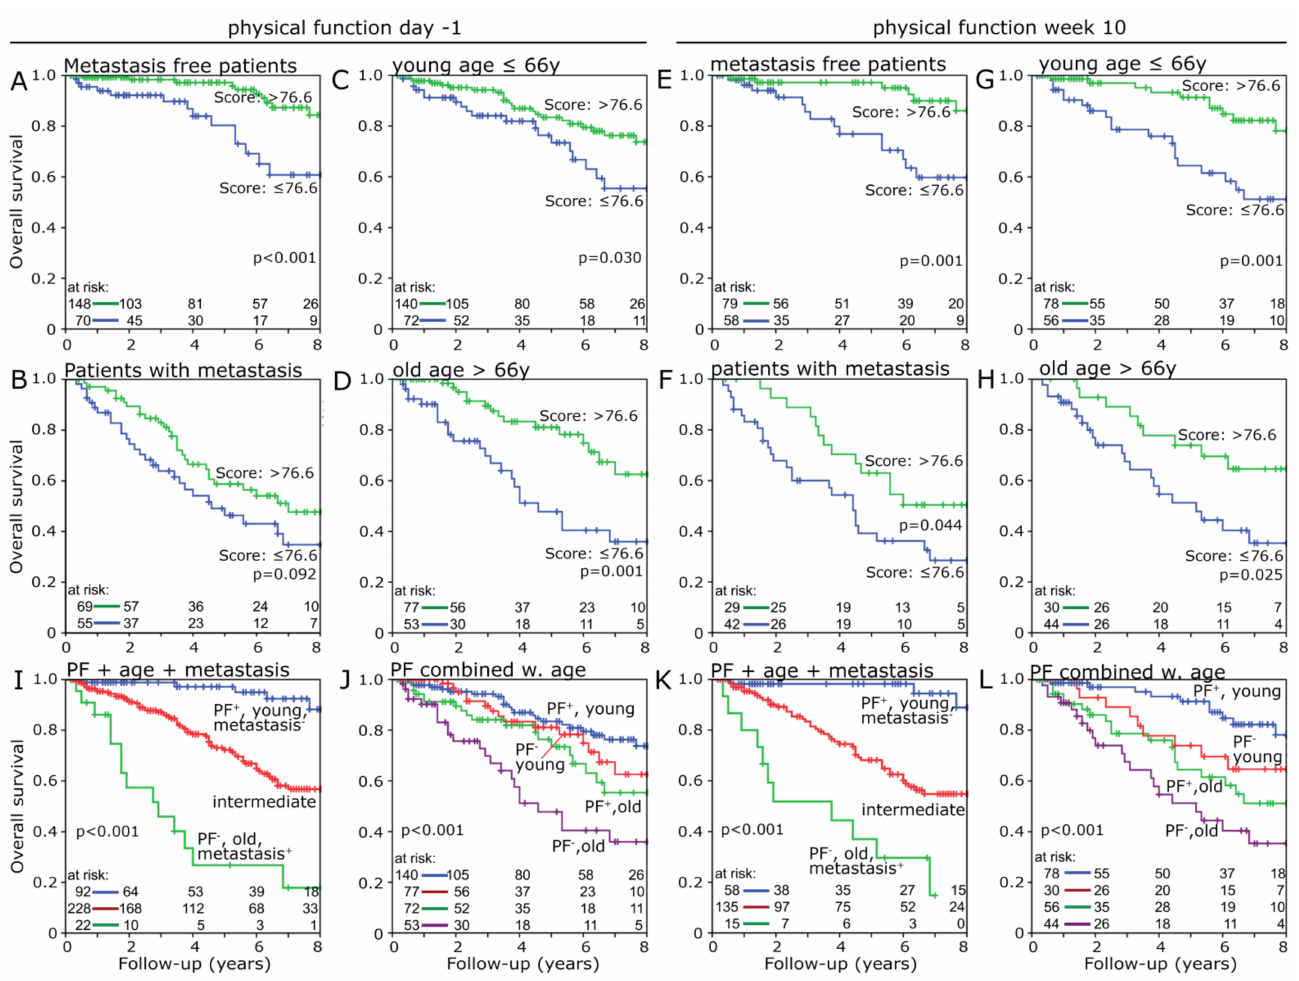
Figure 6. Overall survival at day -1 with higher (upper green line) and lower (bottom blue line) scoring “physical function” group in respective subgroups like ( A ) metastasis-free patients, ( B ) patients with metastasis, ( C ) young patients 66 years and below, ( D ) patients older than 66 years. Overall survival at week 10 with higher (upper green line) and lower (bottom blue line) scoring “physical function” group in respective subgroups like ( E ) metastasis-free patients, ( F ) patients with metastasis, ( G ) young patients 66 years and below, ( H ) patients older than 66 years. Overall survival at day -1 ( I ) and week 10 ( J ) comparing the combination (blue line) of high “physical function”, young age and metastasis-free (green line) with low “physical function”, high age and metastasis-positive and the intermediate group (red line), which include all patients with a mix of favorable and unfavor- able attributes. Overall survival at day -1 ( K ) and week 10 ( L ) comparing all combinations of high and young age and high and low “physical